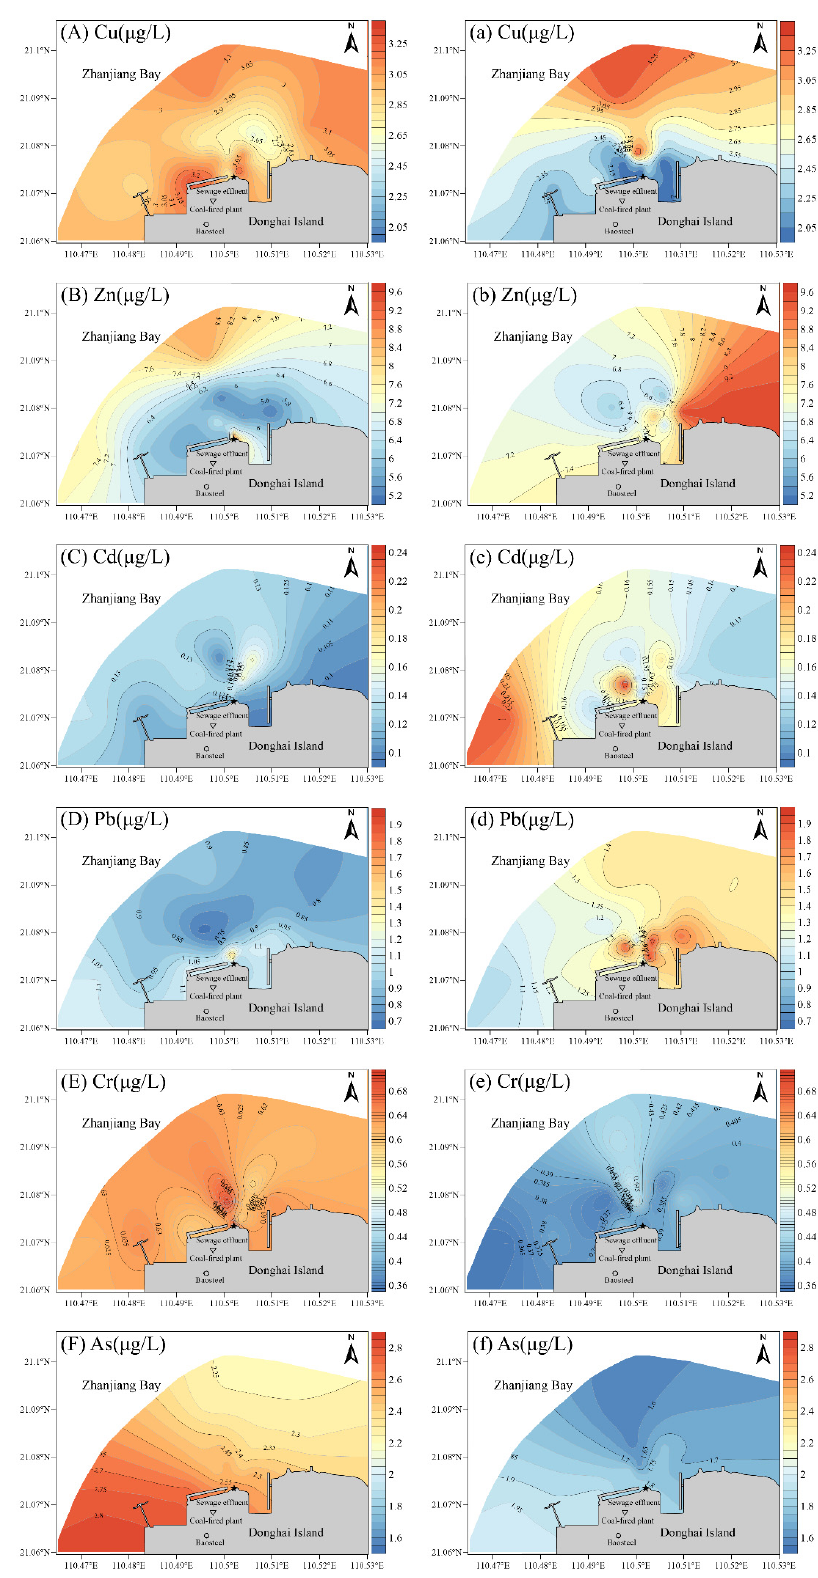
Figure 2. The distribution characteristics of the concentrations of heavy metals Cu, Zn Cd, Pb, Cr and As in the surface seawater. ( A – F ) shows the distribution characteristics of the concentrations of heavy metals during the normal operation of seawater desulfurization process. ( a – f ) shows the distribution characteristics of heavy metals after seawater desulfurization process